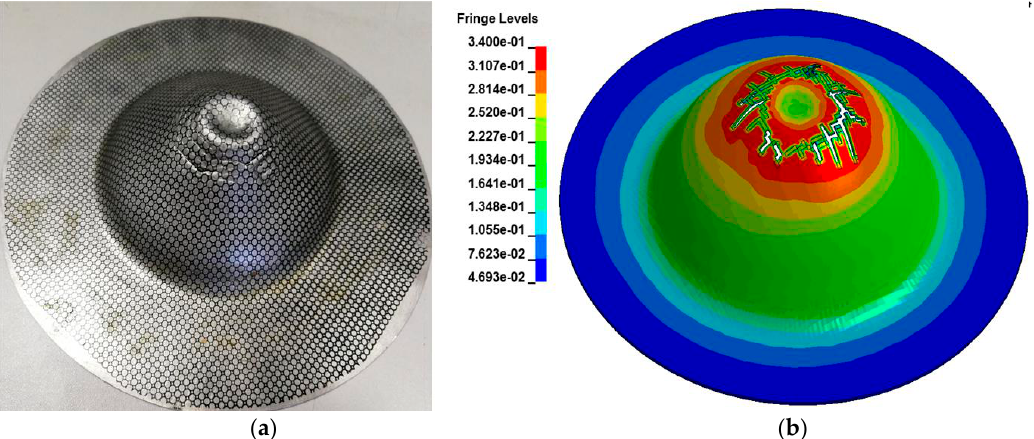
Figure 24. ( a ) Experimental; and ( b ) simulation-predicted fracture specimen impact to the cylinder-shaped die.